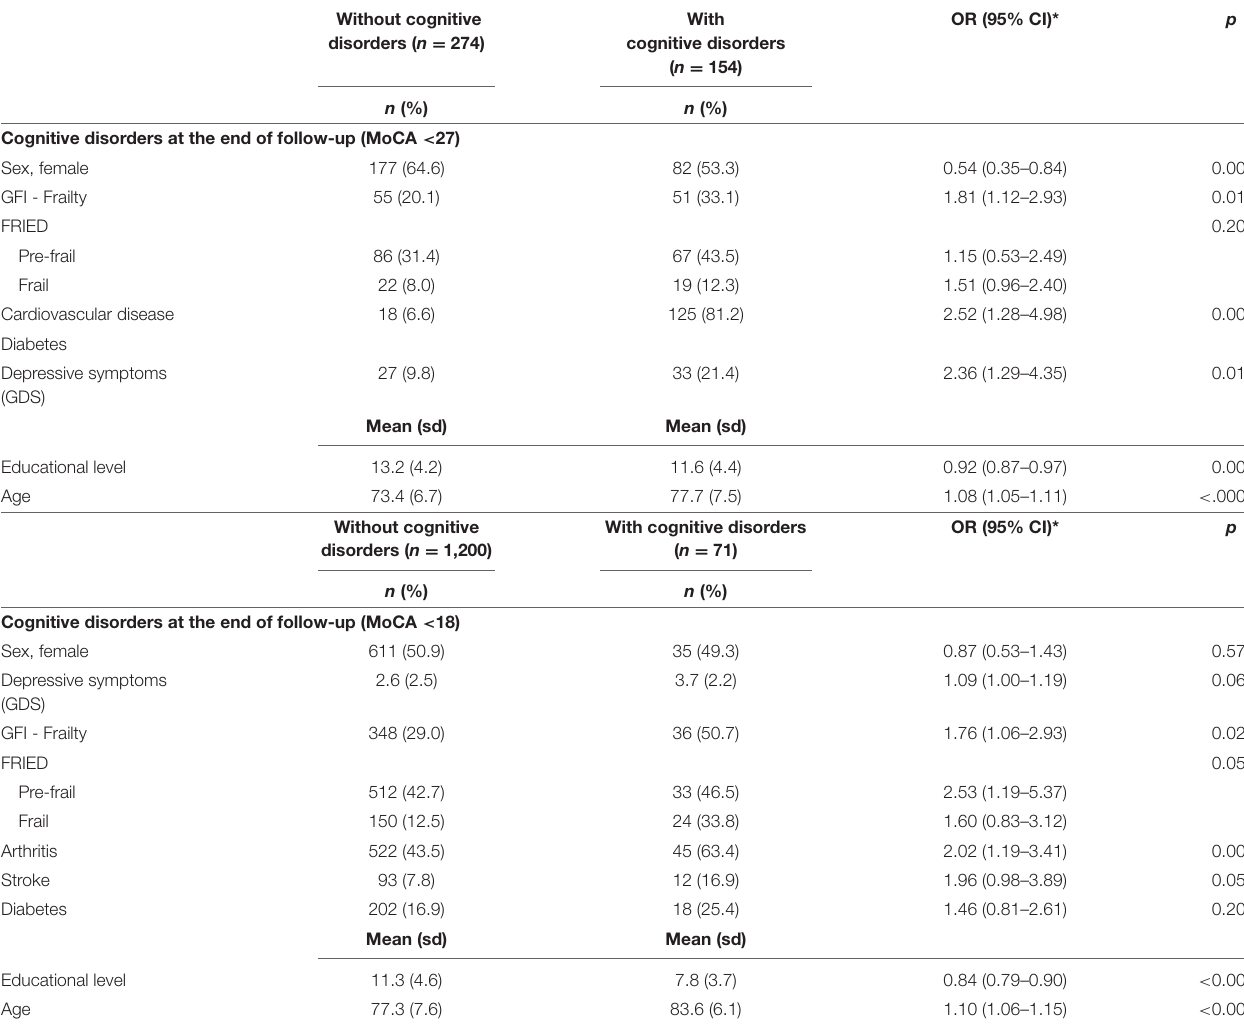
TABLE 1 | Baseline characteristics and cognitive disorders incidence during follow-up.